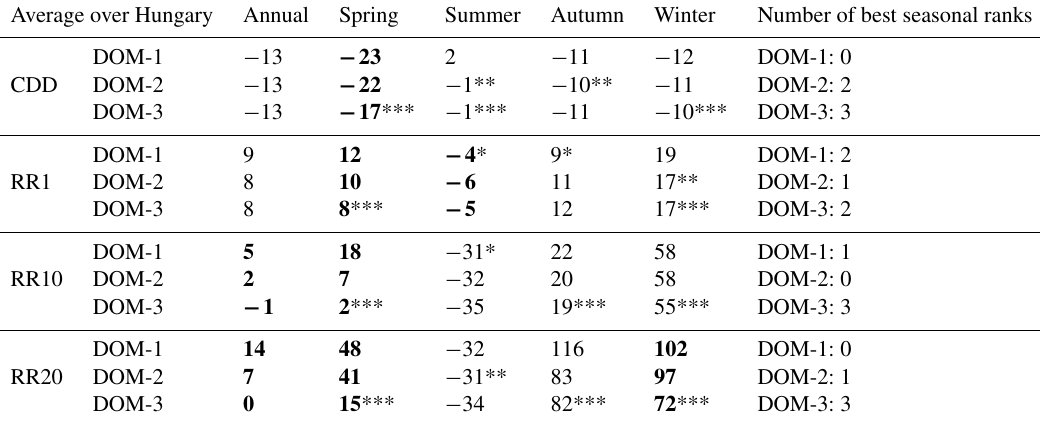
Table 4. The relative bias (%) of the annual and seasonal averages of the different precipitation indices between the results of the REMO model simulations and the CarpatClim-HU data in the period 1971–1980 for Hungary. The model experiments describing the given indices in a given season with the smallest error were marked (*: DOM-1, **: DOM-2, ***: DOM-3). In the last column of the table, we summarised how many seasons the given domain proved to be the best for a given index. In addition, if the deviation between the biases for all experiments exceeds 10% in relative terms for a given index in a given season, it is indicated in bold. The given indices are the follows: CDD (maximum no. of consecutive dry days, RR < 1mm), RR1 (no. of wet days, RR ≥ 1mm), RR10 (heavy precipitation days, RR ≥ 10mm) and RR20 (very heavy precipitation days, RR ≥ 20mm).